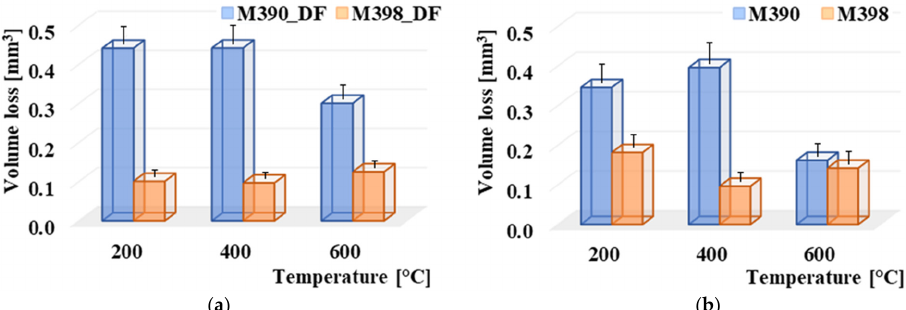
Figure 8. Comparison of wear of materials M390 and M398: ( a ) wear of materials with cryogenic treatment; ( b ) wear of materials without cryogenic